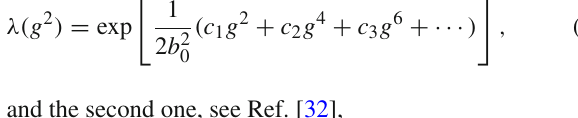
Table 1 Critical value of β c = 4 / g 2 for different values of N τ from